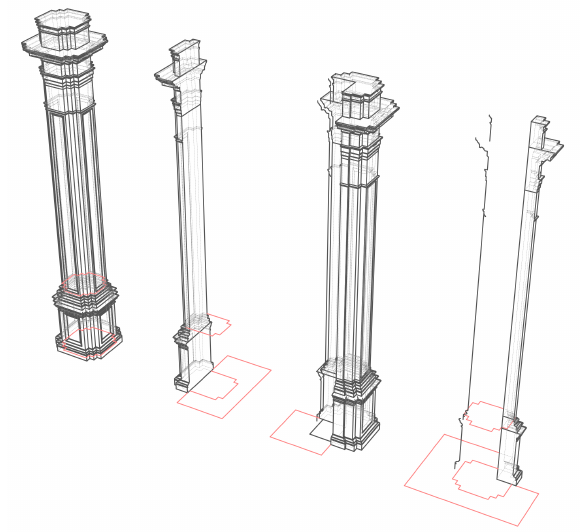
Figure 4. Model of the classical main order and its